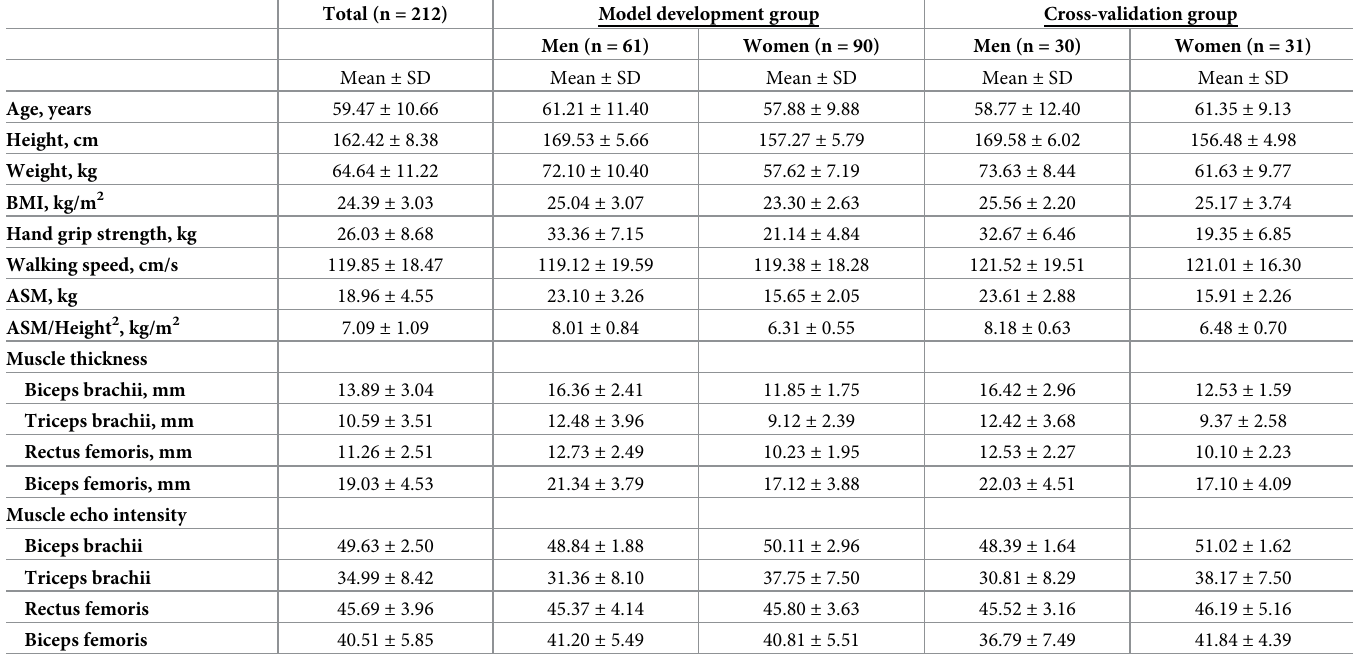
Table 1. Demographic and clinical characteristics of the study